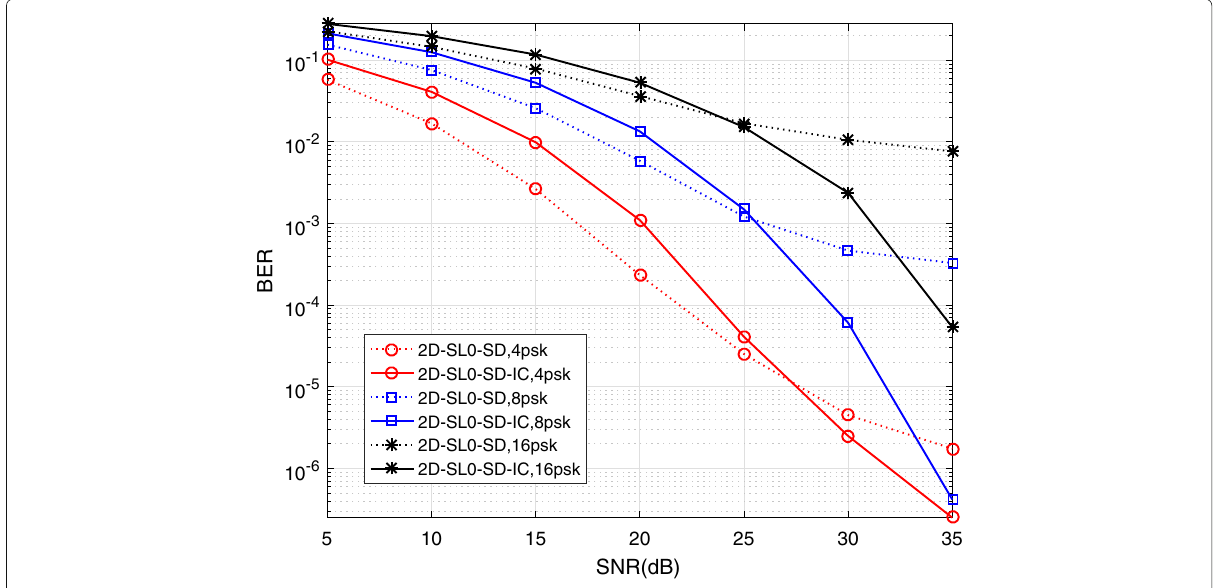
Fig. 3 BER of 2D-SL0-SD with perfect